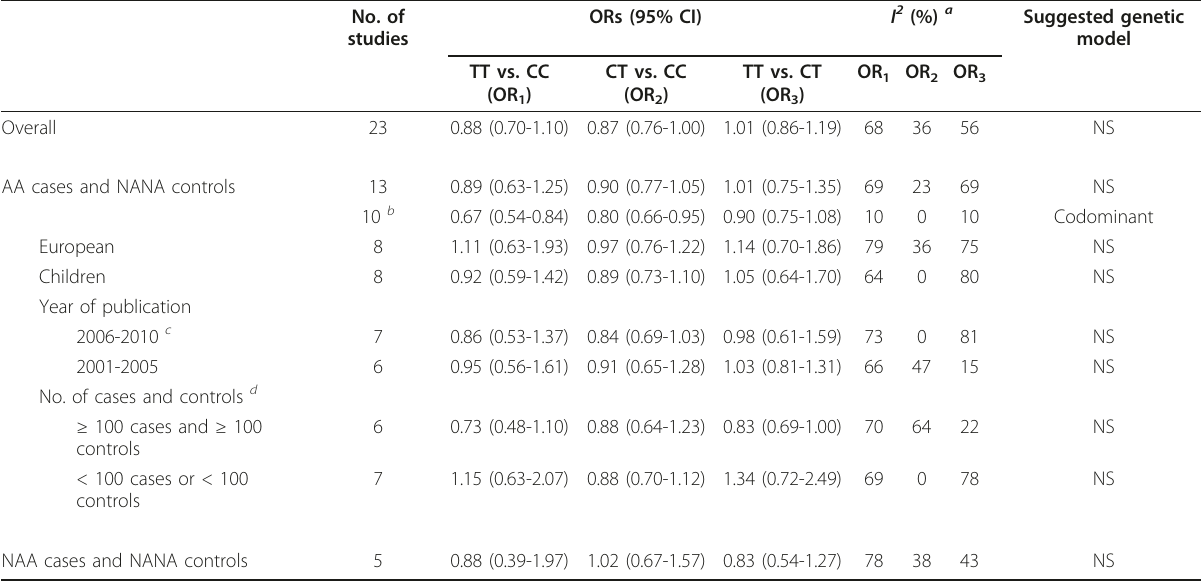
Table 2 Estimated ORs for CD14 -260 ( -159 ) C>T and asthma